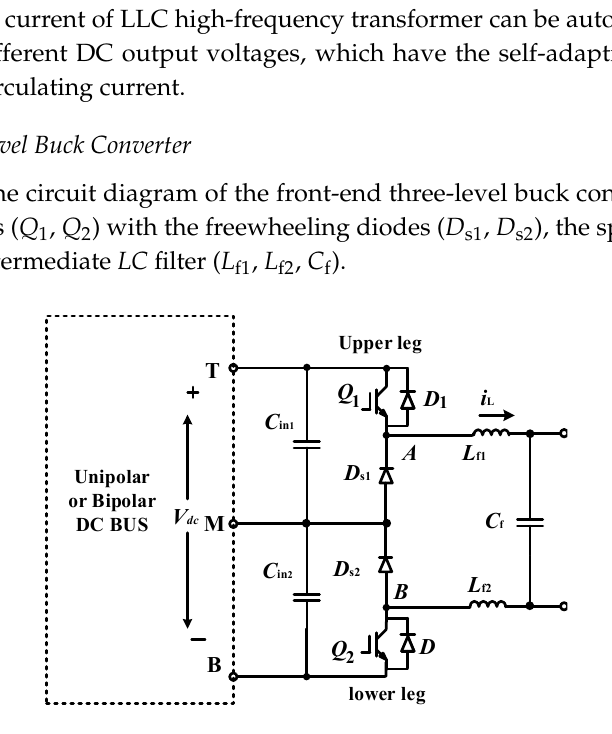
Figure 3. Front-end three-level buck converter topology.